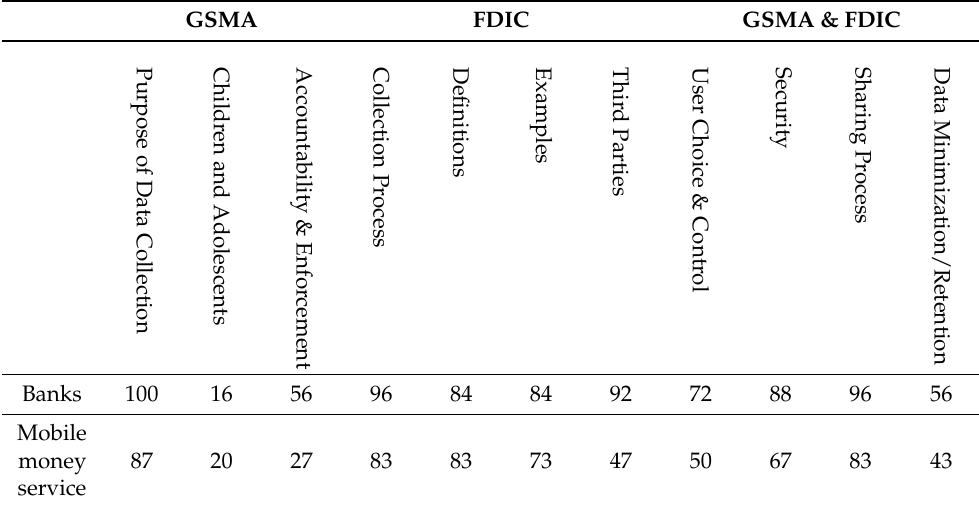
Table 3. Overall percentage (%) of investigated banks and mobile money services complying with each of the GSMA and FDIC